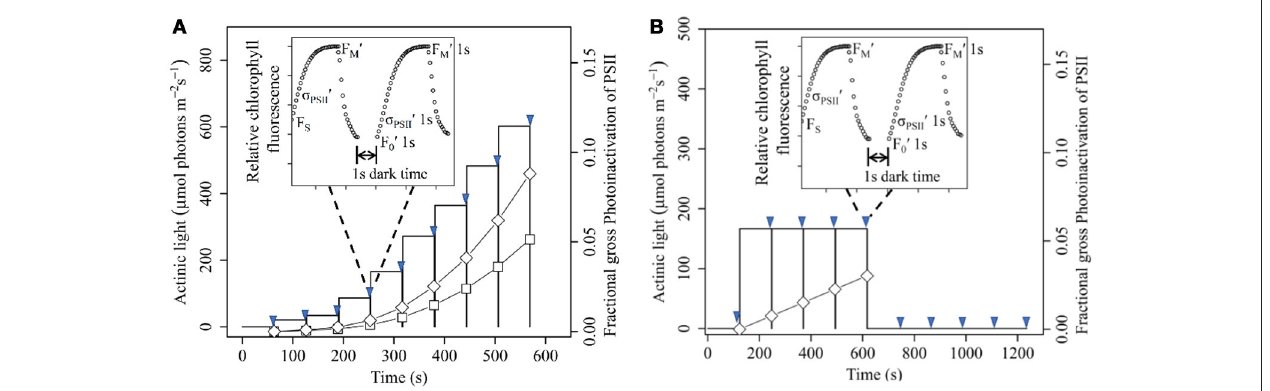
FIGURE 1 | Light Response (A) and Saturating Light (B) treatment and measuring protocols. Arrowheads show applications of repeated Fast Repetition and Relaxation chlorophyll fluorescence measurements, as shown in representative annotated inset graphs. At each measurement we applied a first fluorescence induction and relaxation in the presence of background actinic light, and then again after 1s of dark to allow re-opening of Photosystem II. One 1s dark intervals are indicated by vertical lines separating flashlet steps of light treatment protocols. On the right Y axis we plot the estimated gross, cumulative photoinactivation of PSII during the treatments for Ostreococcus (open diamonds) or Thalassiosira (open squares) from growth-limiting light. Net photoinactivation would be lower through PSII